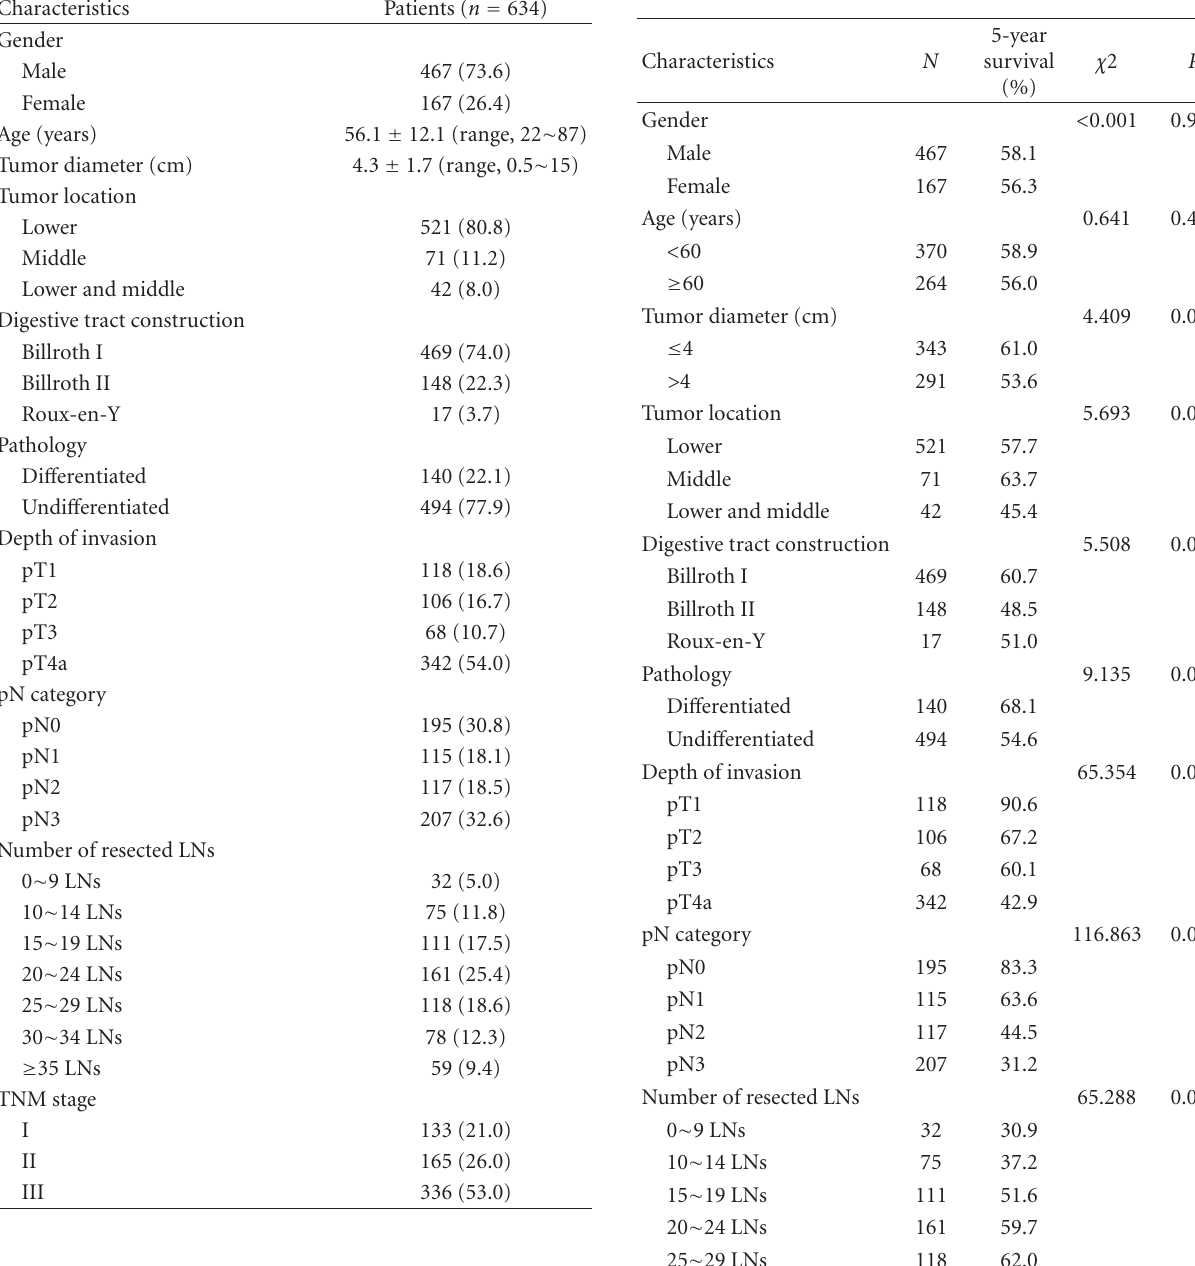
Table 1: Clinical characteristics of the 634 patients. Table 2: Univariate analysis of variables for patients with curative distal